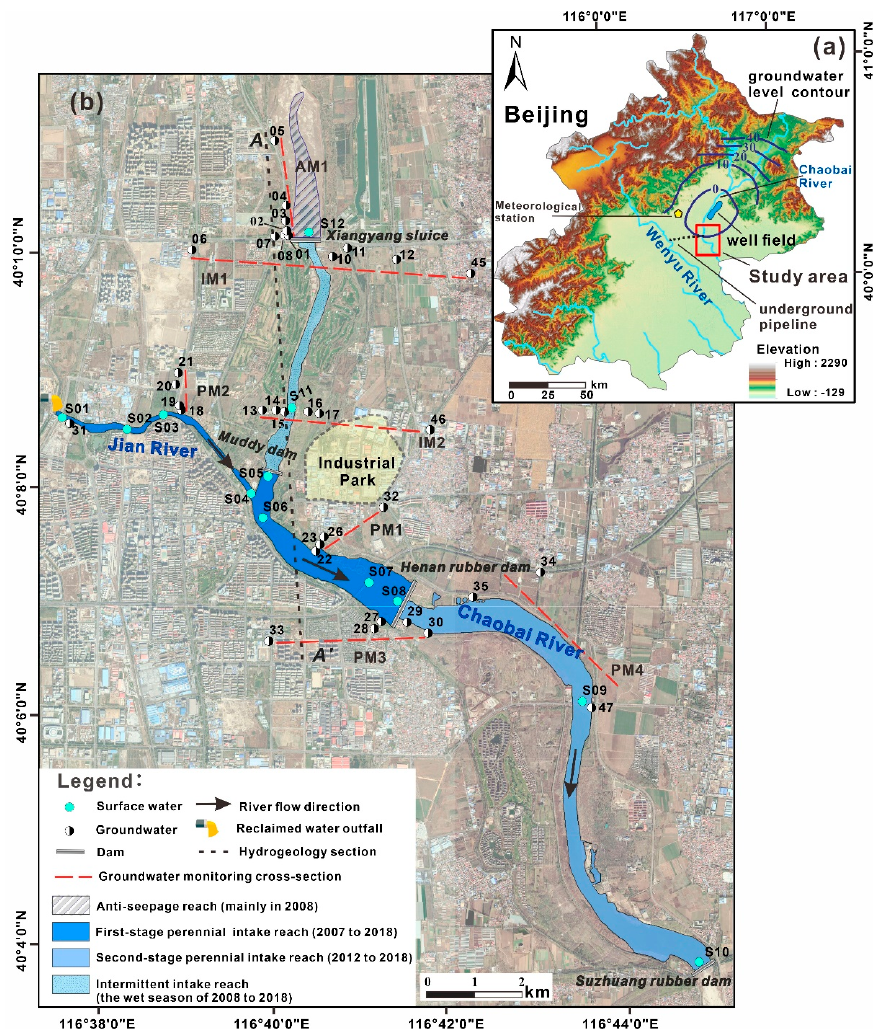
Figure 1. ( a ) Location map for showing investigated sites in the Chaobai River, Beijing, north China; ( b ) can be zoomed from Figure 1a, showing the water sampling locations and groundwater monitoring cross-sections. The time of reclaimed water transfer in different reaches are shown in brackets. AM: Anti-seepage reach monitoring cross-section; PM: Perennial intake reach monitoring cross-section; IM: Intermittent intake reach monitoring cross-section. Groundwater level contours and depression cone in groundwater (enclosed by 0 m groundwater level) in Nov. 2011 are referenced from Li et al.